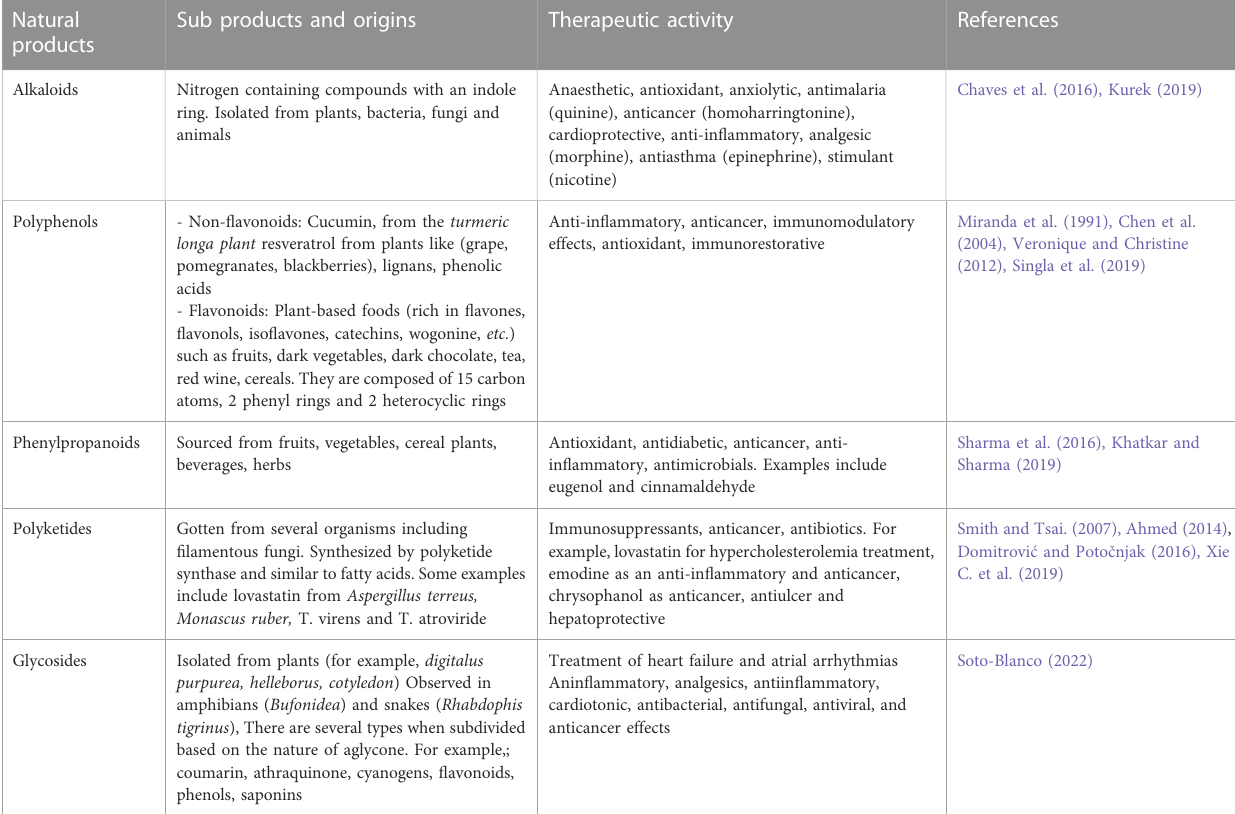
TABLE 2 Natural products, subtypes, and their therapeutic